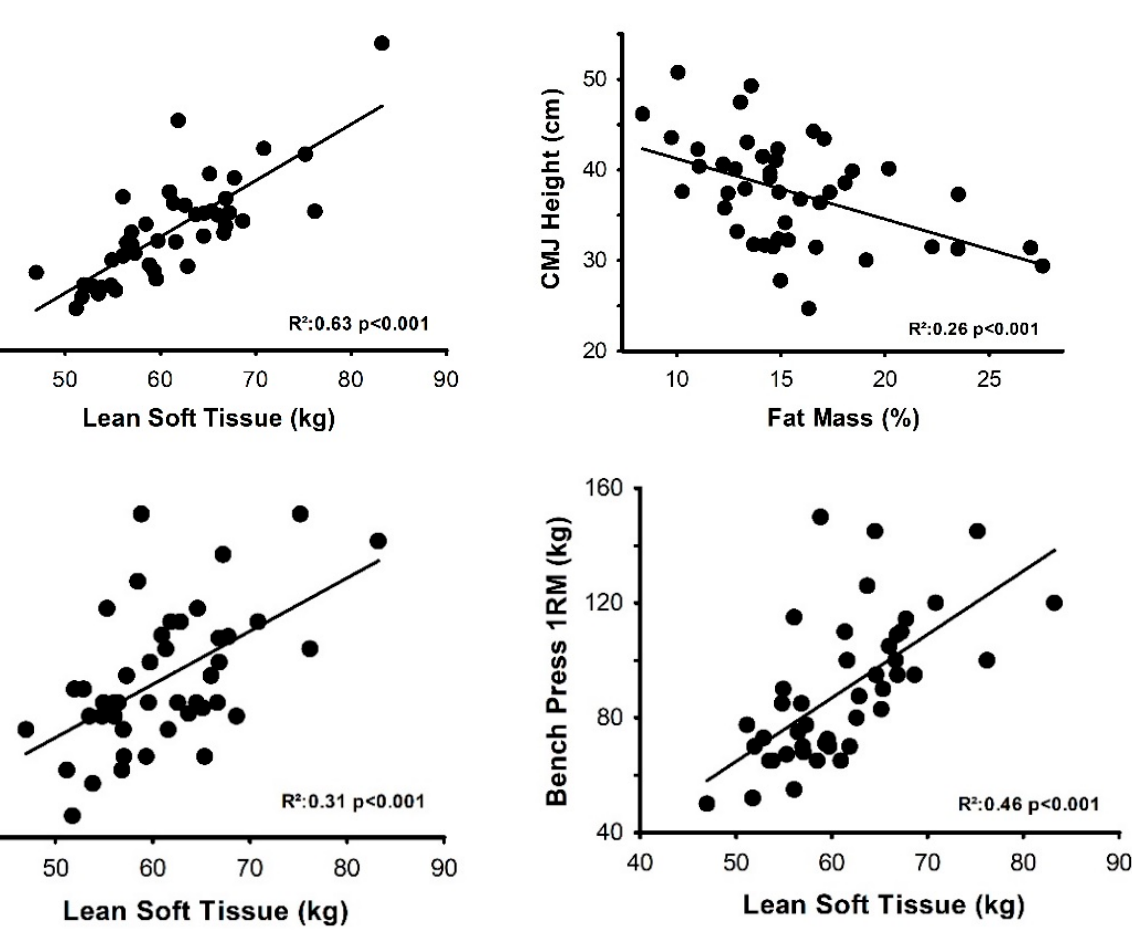
Figure 1. Scatter plots of the associations between performance results in the tests (Wingate test: upper left panel, CMJ “counter movement jump” height: upper right panel, Back squat: lower left panel, Bench press: lower right panel).